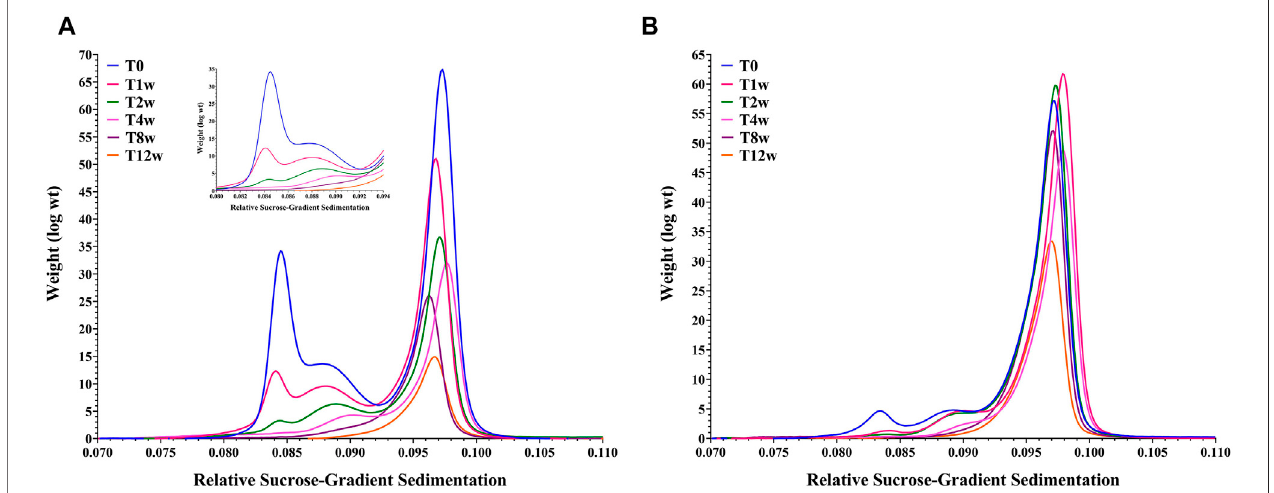
FIGURE 4 | Overlay of Differential Centrifugation Sedimentation data for an AdC68 #1 (Panel A) and AdC68 #2 (Panel B) accelerated stability time